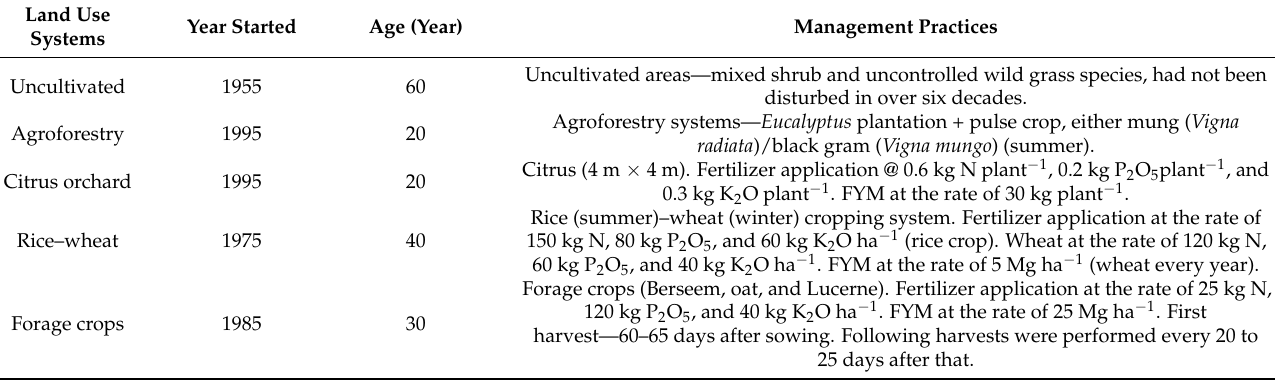
Table 1. Description of land use systems prevailed in the hot arid regions of India.